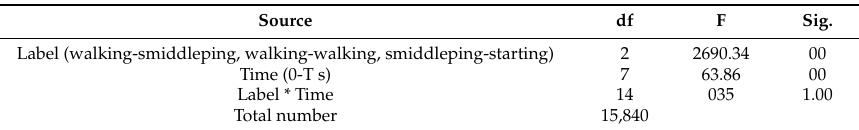
Table 2. Post ‐ hoc comparison table. Label